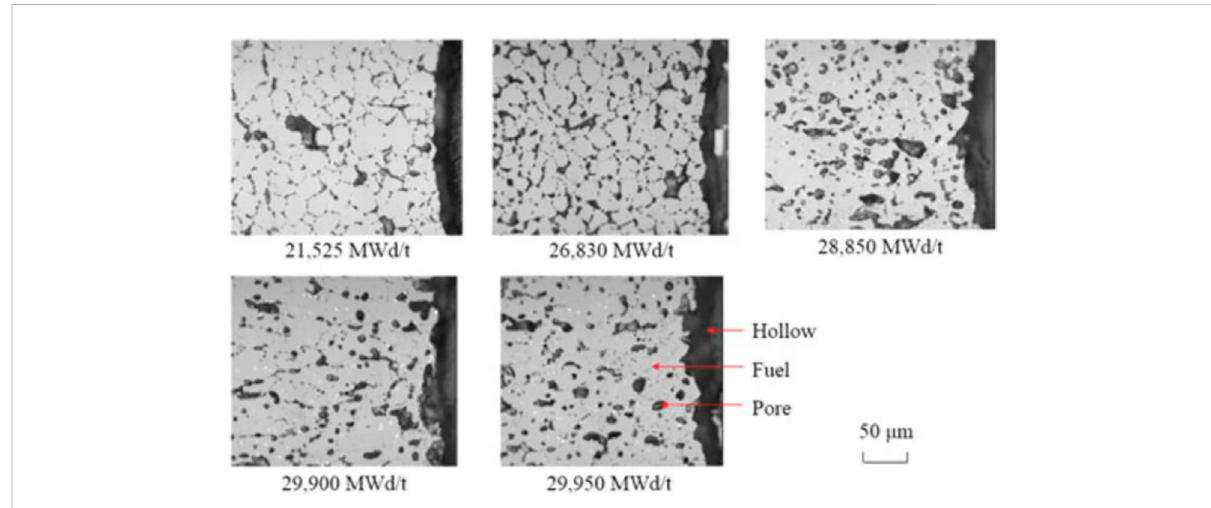
FIGURE 14 Microstructures of fuel region around the hollow fuel pellets at different burnups (Ishimi et al., 2016).